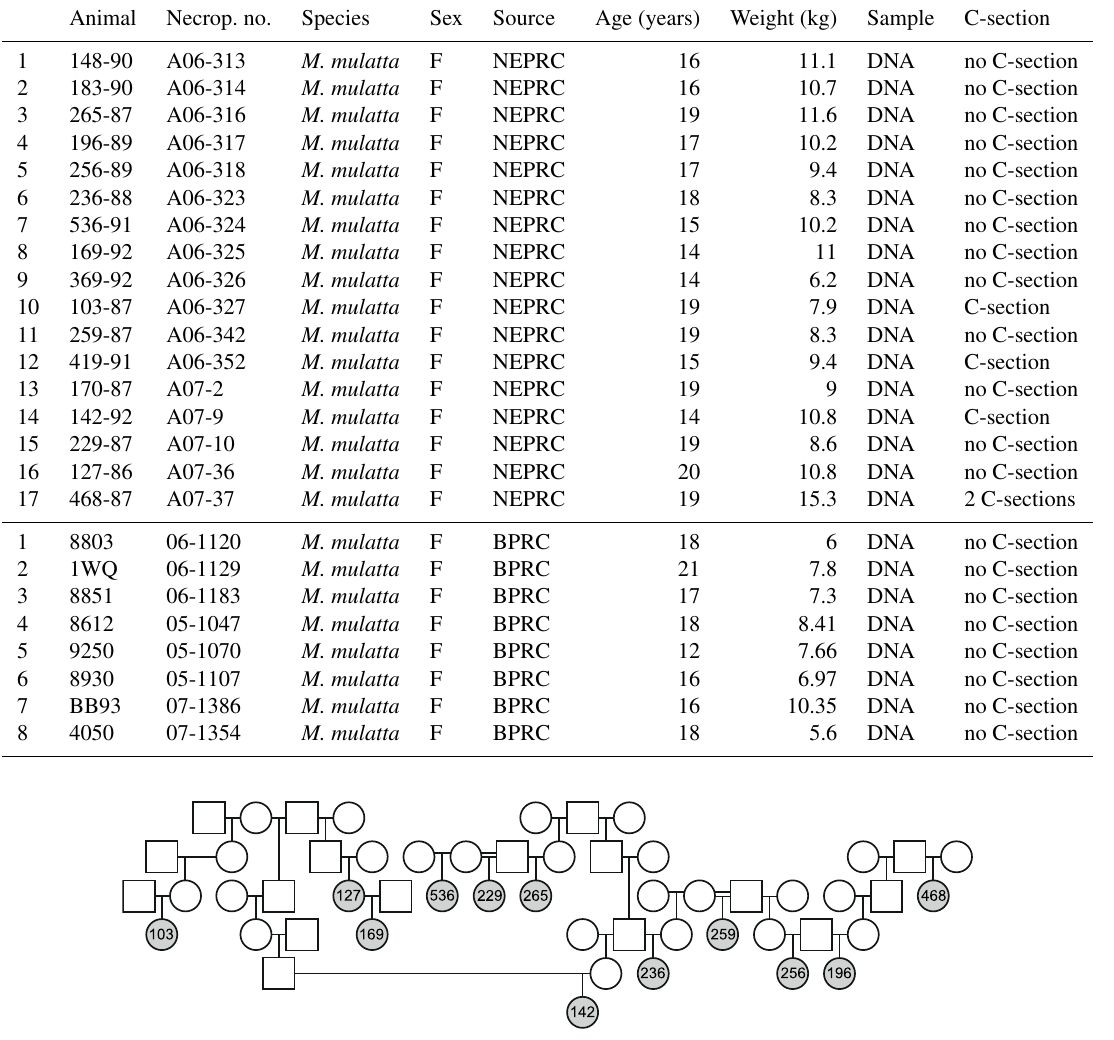
Table 1. Cohorts of rhesus macaques with endometriosis housed at NEPRC and BRPC shown with age, body weight, and surgical history of caesarian sections.